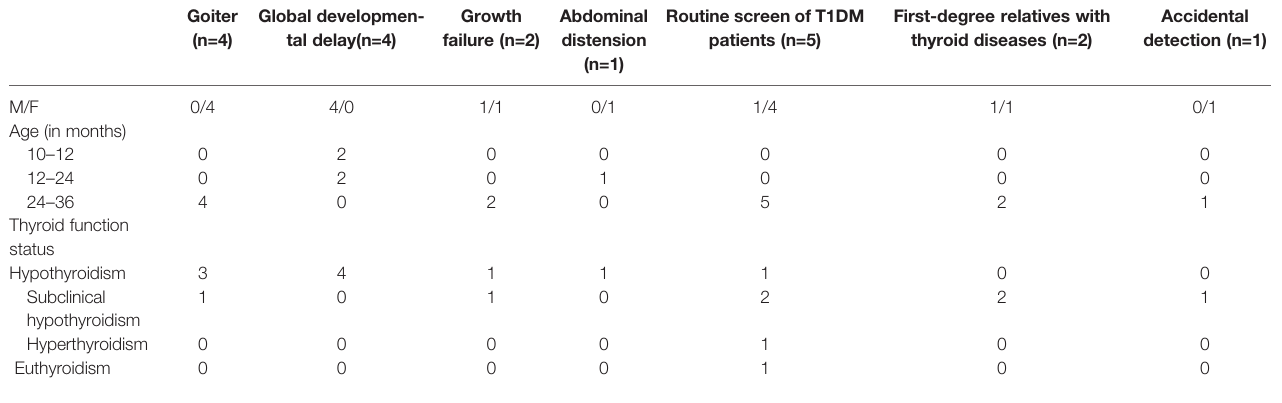
TABLE 3 | Initial thyroid function status strati fi ed by reason for the initial visit in 19 children with